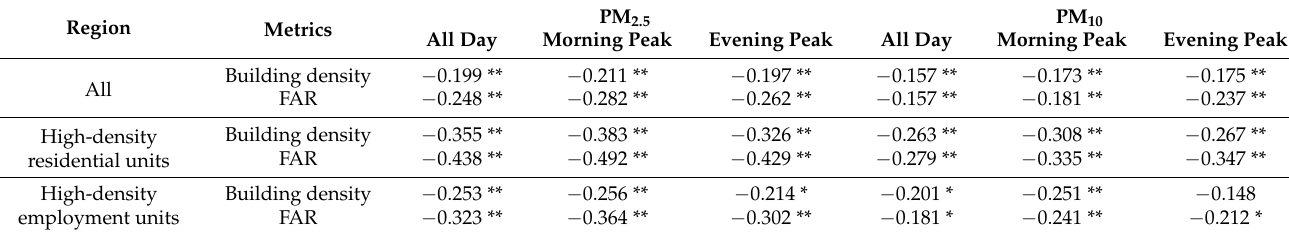
Table 1. Correlation between air pollution concentration, building density, and